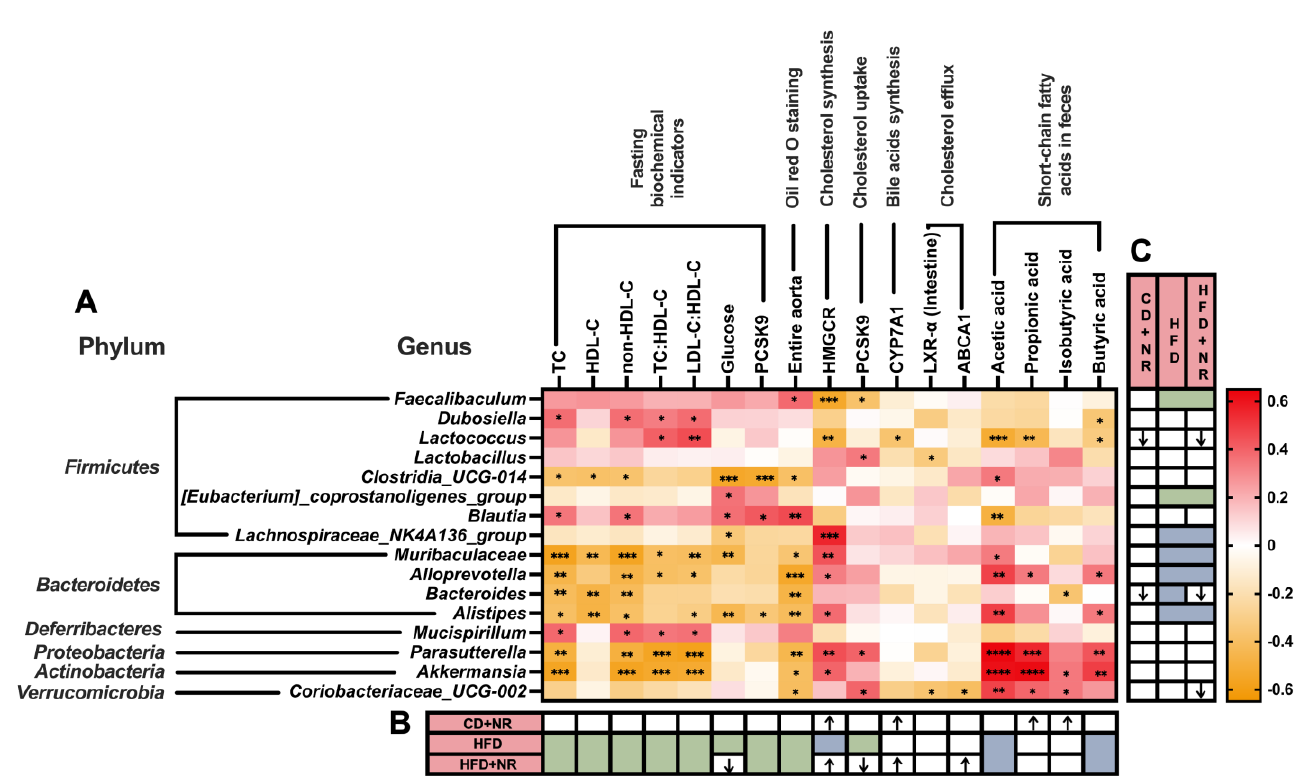
Figure 5. ( A ) Correlations between the relative abundance of gut microbiota (Top 16 genera) and blood biochemical parameters, Oil Red O staining of aorta, gene expressions in cholesterol metabolism and concentrations of SCFAs in ApoE −/− mice fed with a CD and HFD, without or with NR at the end of the study. ( B ) Changes of corresponding parameters after different diet and NR interventions. ( C ) Changes in the relative abundance of gut microbiota after different diet and NR interventions. Pearson or Spearman correlation tests were used depending on the normality of the data (N = 41). The data were presented as Pearson or Spearman correlation coefficients. * p < 0.05, ** p < 0.01, *** p < 0.001, and **** p < 0.0001 indicate statistically significant correlations. CD (control), n = 10; CD+ NR, n = 11; HFD, n = 10; HFD + NR, n = 10. CD, control diet; HFD, high-fat and high-cholesterol diet; + NR, a diet with 0.3 g/kg BW/day supplementation of natto and red yeast. ↑ represented the parameters in the CD + NR group or the HFD + NR group that were significantly higher than those in the CD group or HFD group, respectively. ↓ represented the parameters in the CD + NR group or the HFD + NR group were significantly lower than those in CD group or HFD group, respectively. The color blue or green in the merged grid that represented the parameters in both HFD groups were significantly lower or higher than those in both CD groups. The color green in a single grid that represented the parameters in the HFD group were significantly higher than the CD group.